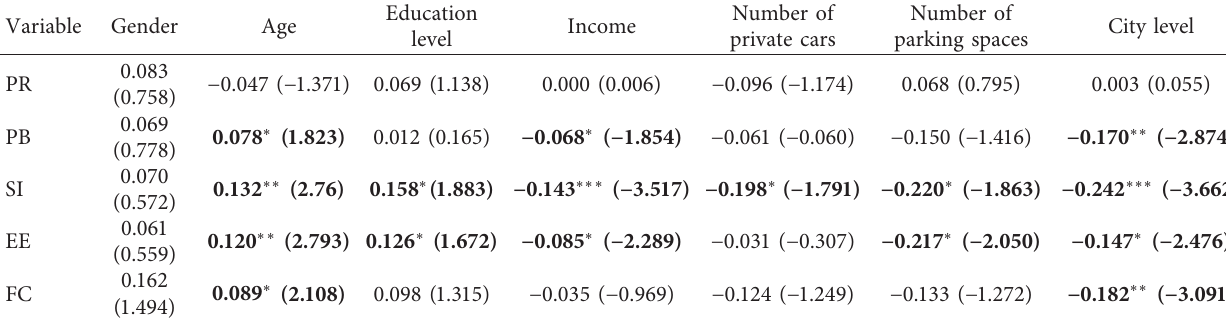
Table 8: Influence of exogenous factors on latent variables.